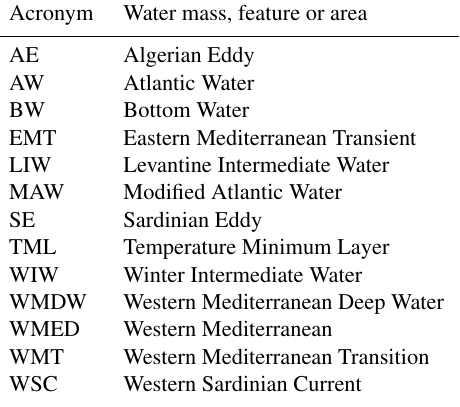
Table 1. Abbreviations of water masses, features, and areas used in this study. The acronyms mainly correspond to the recom- mendations of the round table session on Mediterranean Wa- ter Mass Acronyms at the 36th CIESM (Commission Interna- tionale pour l’Exploration Scientifique de la mer Méditerranée) Congress in Monte Carlo in September 2001 (http://ciesm.org/